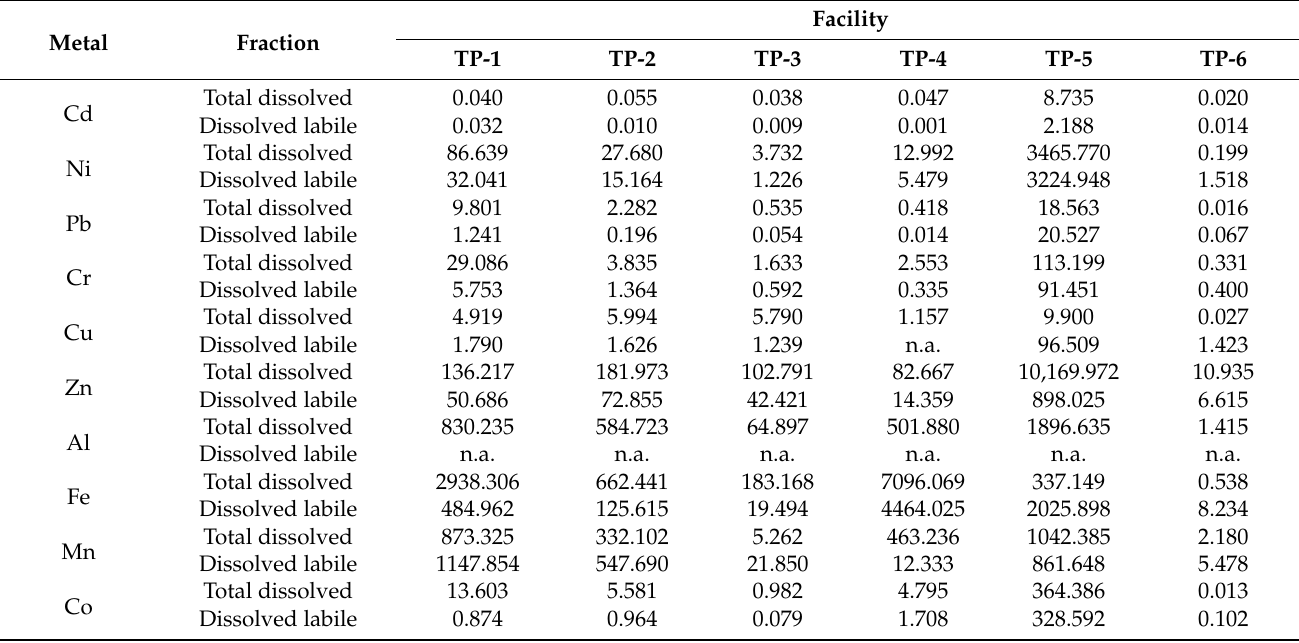
Table 3. Estimation of the daily specific loads (g/day) of total dissolved and dissolved labile metals for the facilities under